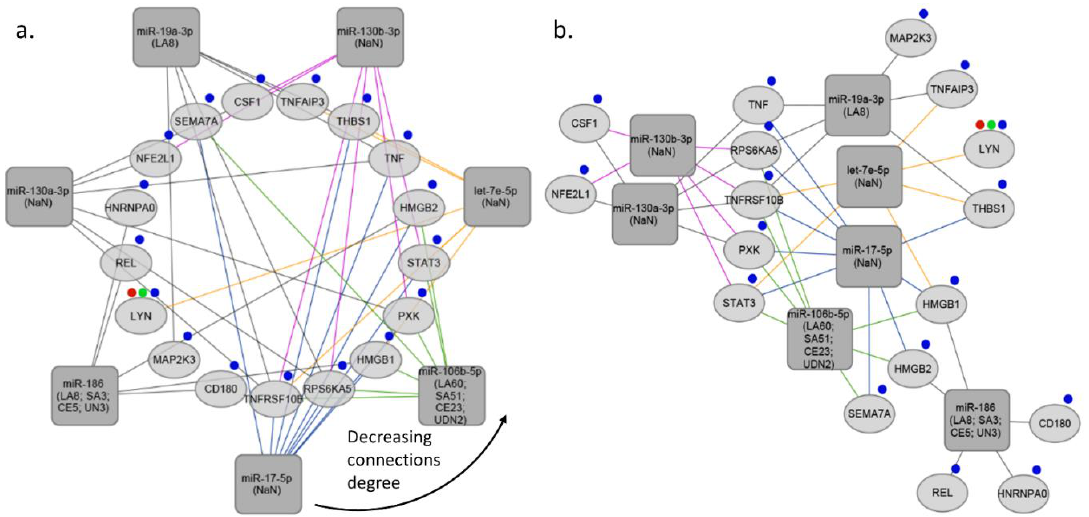
Figure 2. miRNA-target gene networks based on inflammatory response. ( a ) Inflammatory response-network sorted by the degree of connections, ( b ) Inflammatory response-interaction network. The rectangles indicate the stroke type miRNAs, the ellipses indicate target genes. Red, green and blue marks represent specific GO process-blood coagulation, platelet activation, and inflammation process, respectively. LA, large artery stroke; SA, small artery stroke; UDN, stroke due to undetermined cause; CE, cardioembolic stroke; NaN, no data.